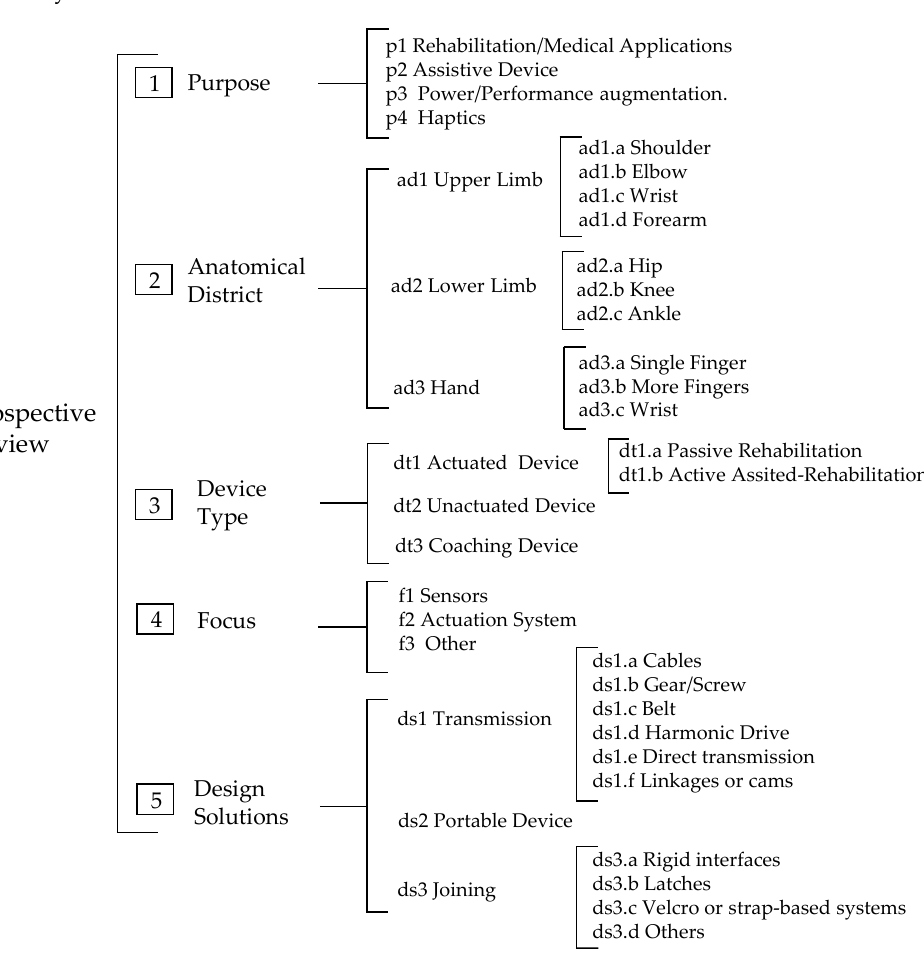
Figure A1. Adopted taxonomy for the